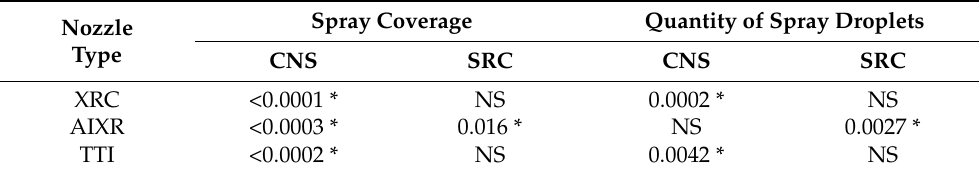
Table 3. ANOVA results ( p -values) for spray coverage and quantity of spray droplets by nozzle type for CNS and SRC. CNS represents the sprayer without a rate controller and SRC represents the sprayer equipped with a rate controller used in this